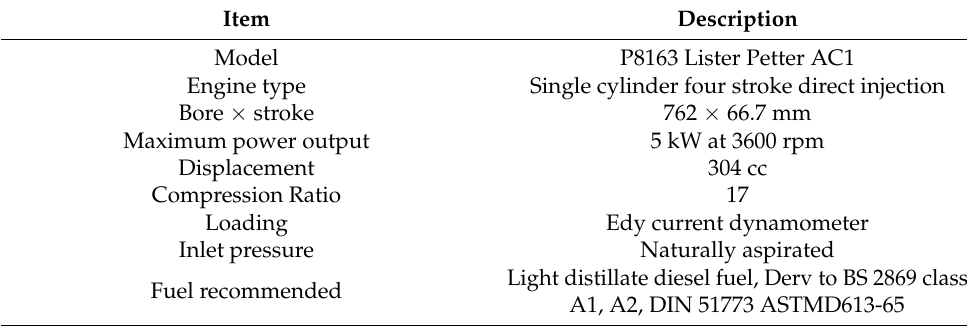
Table 1. Specifications of the test